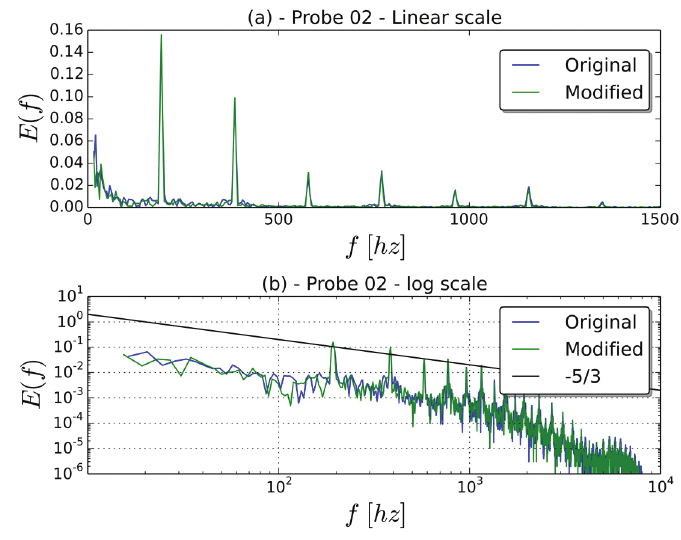
Figure 32 - Energy spectra for probe 2 ; (a) : in linear scale; (b) : log